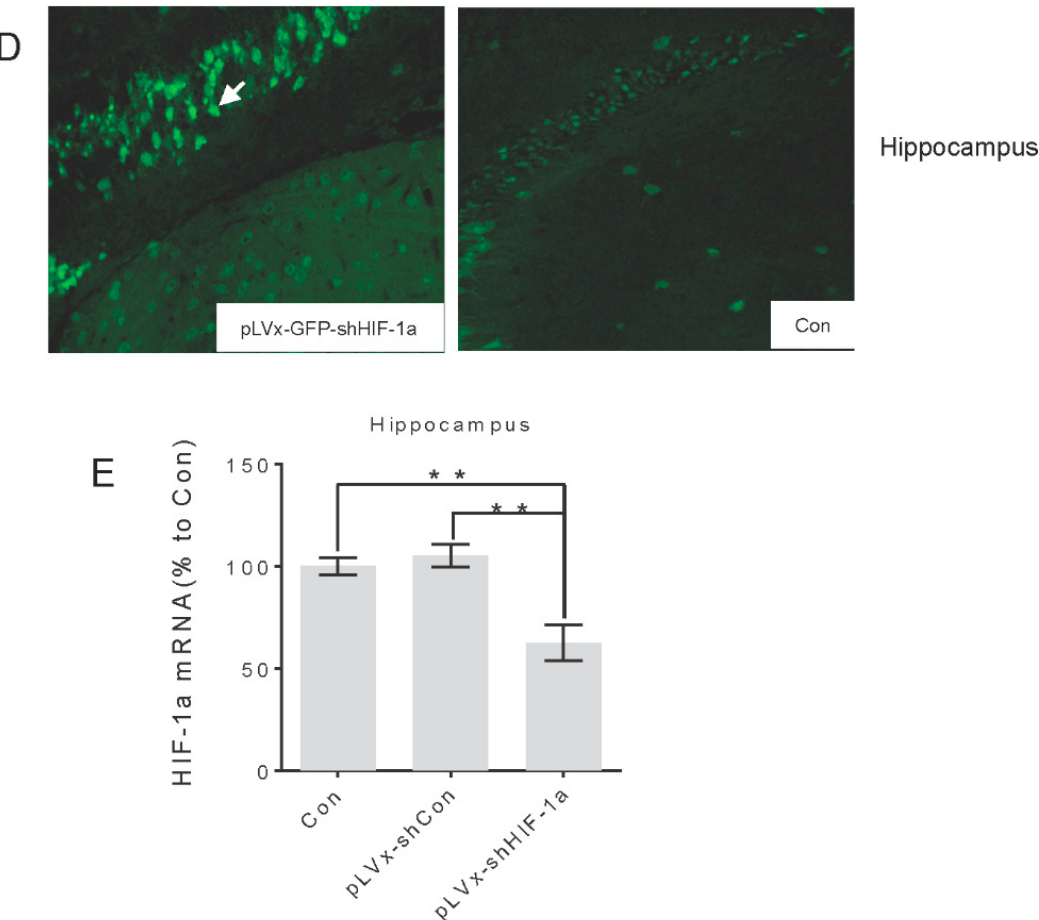
Figure 1. The delivery efficiency of lentivirus vectors and its efficacy in reducing hypoxia inducible factor 1 α ( HIF-1 α ) mRNA expression in normal rats one week after stereotaxic injection. ( A , B ) Injection sites in ventricle and hippocampus. Red lines represent needle tracks; ( C ) GFP+ cells (arrows) in cortex of pLVx-GFP-shHIF-1 α -injected rat ( left ) and saline-injected control rat ( right ); ( D ) GFP+ cells (arrow) in hippocampus (DG subregion) of pLVx-GFP-shHIF-1 α -injected rat ( left ) and saline-injected control rat ( right ); ( E ) qRT-PCR analysis of HIF-1 α mRNA levels in hippocampus one week after stereotaxic injection (Con: saline-injected rats; pLVx-shCon: pLVx-GFP-shCon-injected rats; pLVx-shHIF-1 α : pLVx-GFP-shHIF-1 α -injected rats). Values for HIF-1 α mRNA were normalized to β -actin. Values are expressed as a percentage of the average value for saline-injected rats (Con) and are means ± SEM ( n = 4). ** p < 0.01 (one-way ANOVA followed by Bonferroni post hoc tests).